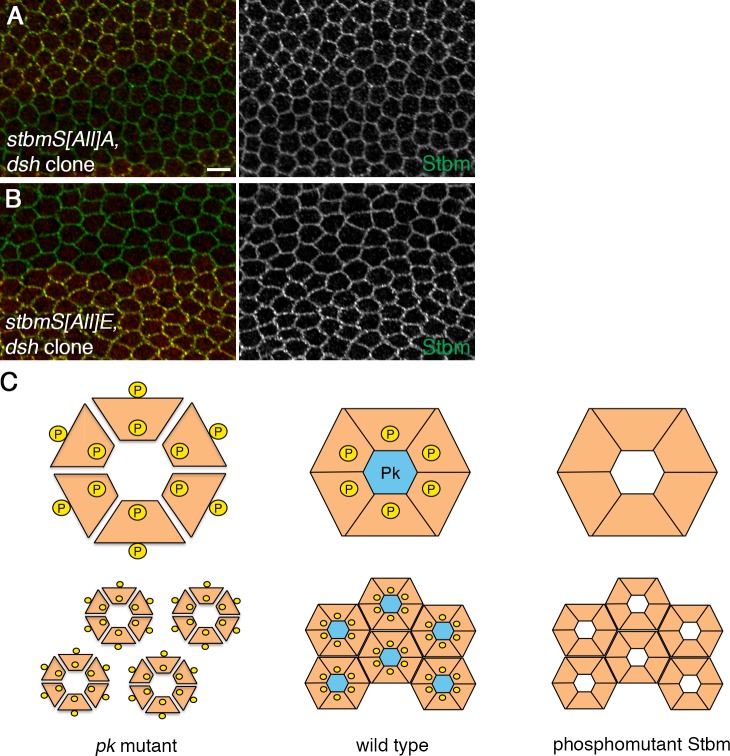
Regulation of Stbm clustering by Dsh and Pk.(A,B) 28 hr APF pupal wings from flies carrying dshV26 clones in a P[acman]-stbmS[All]A stbm6 background (A) or in a P[acman]-stbmS[All]E stbm6 background (B), immunolabelled for Stbm (green) and Dsh (red, note that cytoplasmic as well as junctional Dsh can be seen). Scale bar 5 µm. (C) Speculative model to explain how Pk might reduce Stbm phosphorylation and increase its stability. In the absence of Pk, Stbm (orange boxes) loosely associates into multimers, which are accessible to Dco and highly phosphorylated (yellow circles, top left). This phosphorylation prevents clustering into higher order structures (bottom left). Binding of Pk to Stbm multimers could cause a conformational change that reduces accessibility to Dco (top middle). Reduced phosphorylation would allow clustering of multimers into higher order structures (bottom middle). Phosphomutant Stbm multimerises in the absence of Pk (right), while phosphomimetic Stbm acts like a pk mutant.